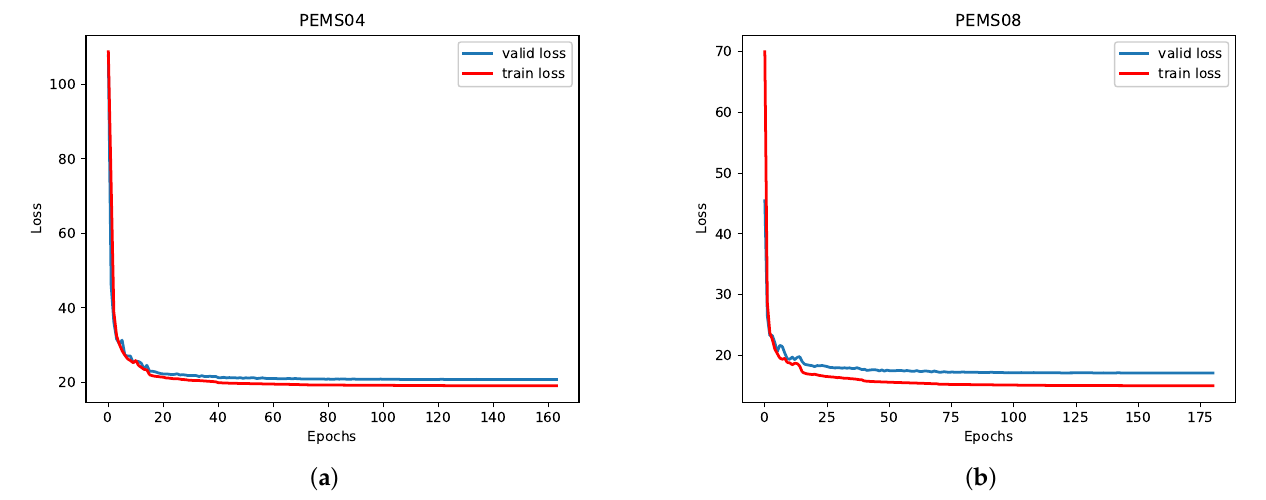
Figure 7. Training and validation error convergence curves on two datasets: ( a ) training and valida- tion error convergence curves on the PEMS04 dataset; ( b ) training and validation error convergence curves on the PEMS08